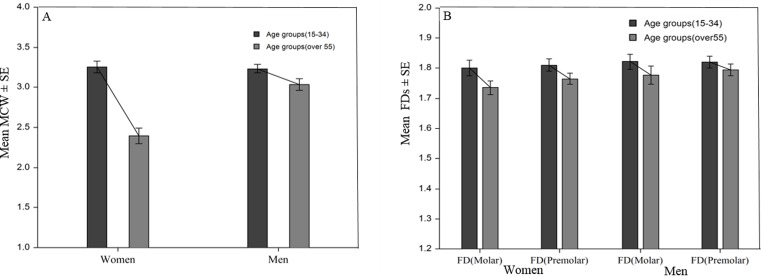
Age and gender associated mean cortical and trabecular variables of the mandible in men and women.Error bars represent standard errors and significance between each groups. (A) Mandibular cortical width (MCW). (B) Fractal dimensions (FD) of trabecular bone at molar and premolar regions.